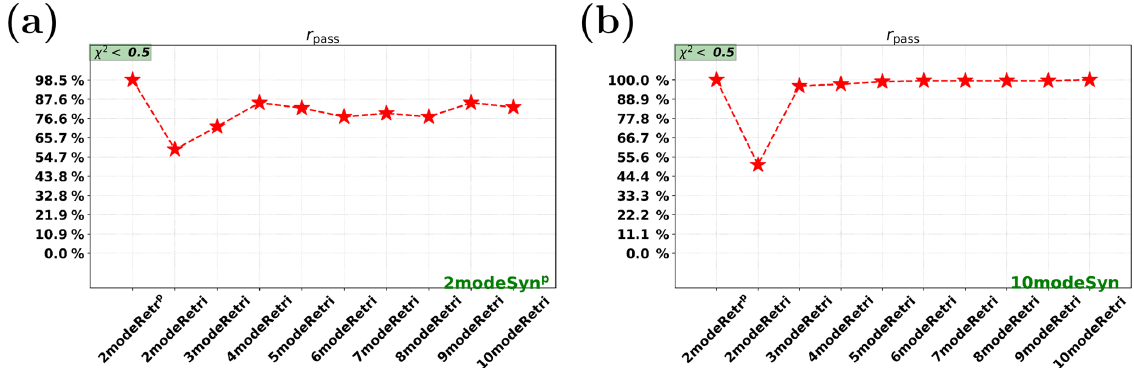
Figure 12. Synthetic retrievals: pass rates when χ 2 < 0 . 5. (a) Retrievals on the parametric two-mode-based synthetic measurement (2modeSyn p ). (b) Retrievals on the 10-mode-based synthetic measurement (10modeSyn). The x axis in the subplot represents the para- metric two-mode retrieval (2modeRetr p ) and different multimode retrieval cases (i.e., 2modeRetr, 3modeRetr, ... ,